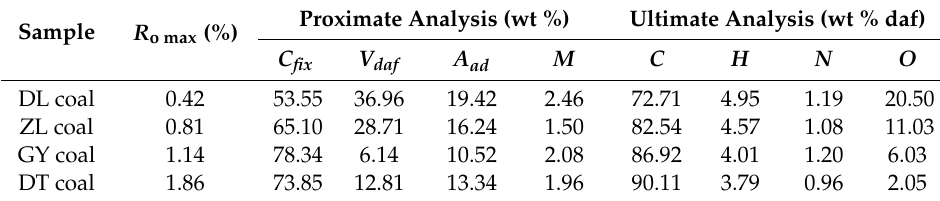
Table 1. Proximate and ultimate analyzes of the coal